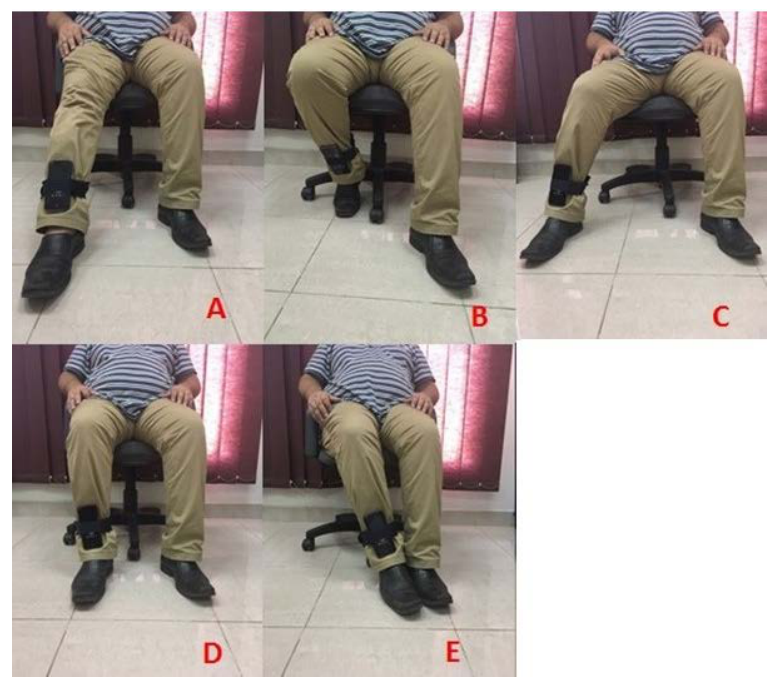
Figure 2. Data Collection Process. (A) Front, (B) Back, (C) Right, (D) Middle (Idle), and (E) Left.